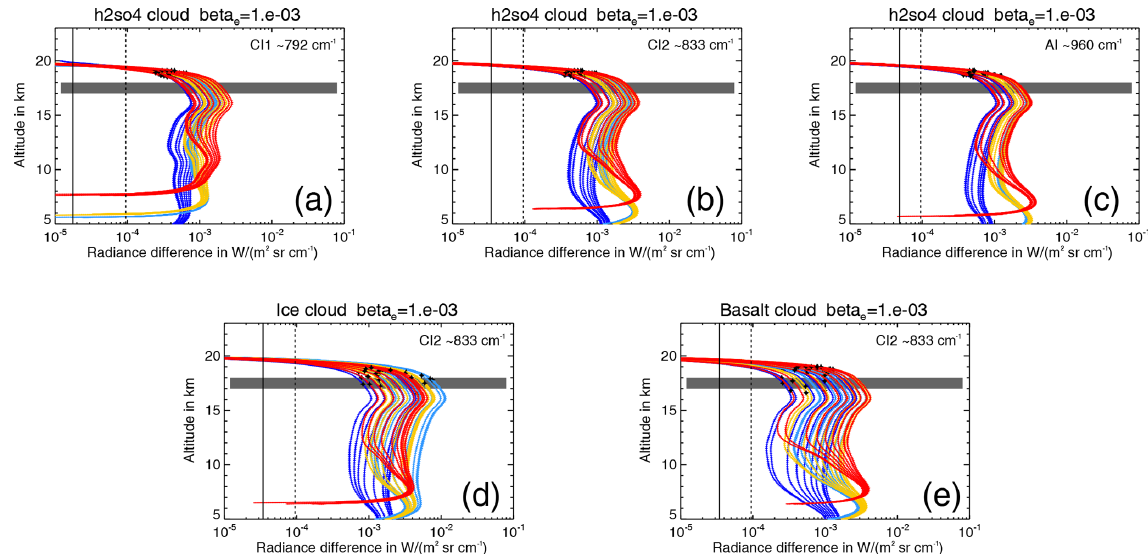
Figure 3. Increase in radiance (cloud – clear air simulation) due to different clouds (solid coloured lines) compared to NESR (black solid line), offset accuracy (black dashed line), and scaling accuracy (dotted coloured lines; very close envelopes around solid coloured lines) for sulfate aerosol in (a) the CI window around 792cm − 1 (CI1), (b) the CI window around 833cm − 1 (CI2), and (c) the AI window around 960cm − 1 , and (d) for ice (e) and ash. The colours indicate the background atmosphere type: red – tropics, yellow – midlatitudes, light blue – polar summer, and dark blue – polar winter. Each line represents one particle size distribution. The black symbols indicate the detected cloud top altitude using ACI = 7. Table 3. Scaling factors for the extinction coefficient of sulfate aerosol from 948.5cm − 1 (10.5µm, MIPAS) to the wavelengths used by selected satellite instruments, the ground-based lidar and twilight measurements, and for the MIPAS